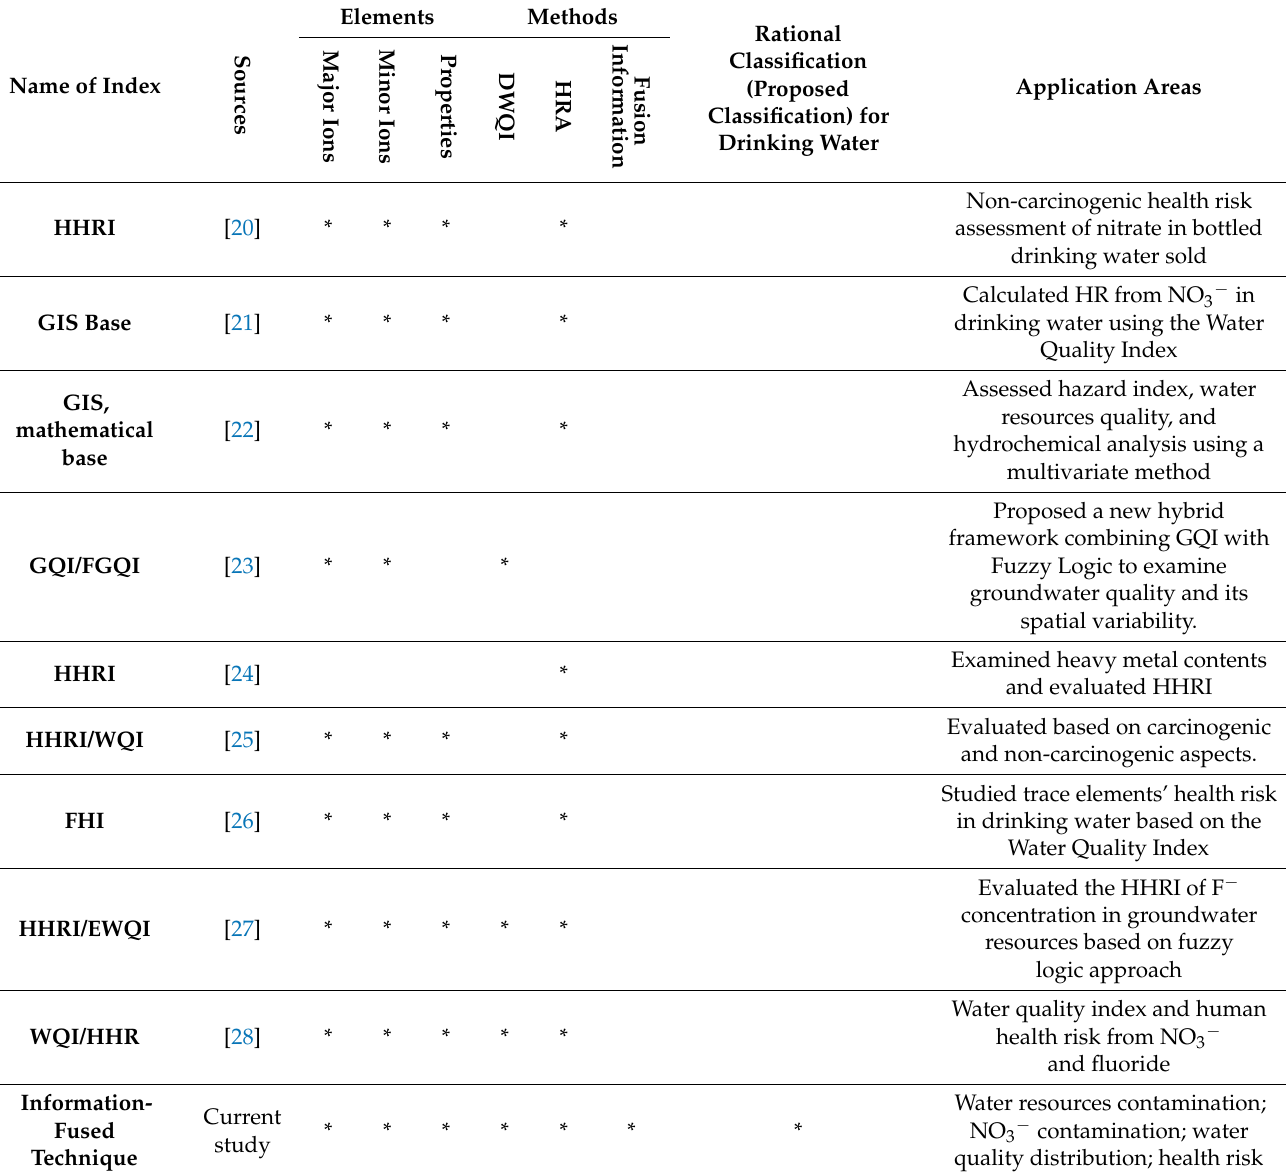
Table 1. Examples of different techniques used in HHRI and